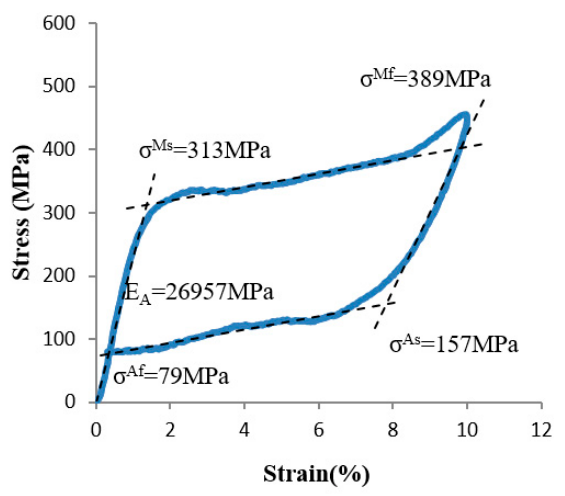
Figure 4. Tensile test curve of SMA sheet with a thickness of 0.2 mm.